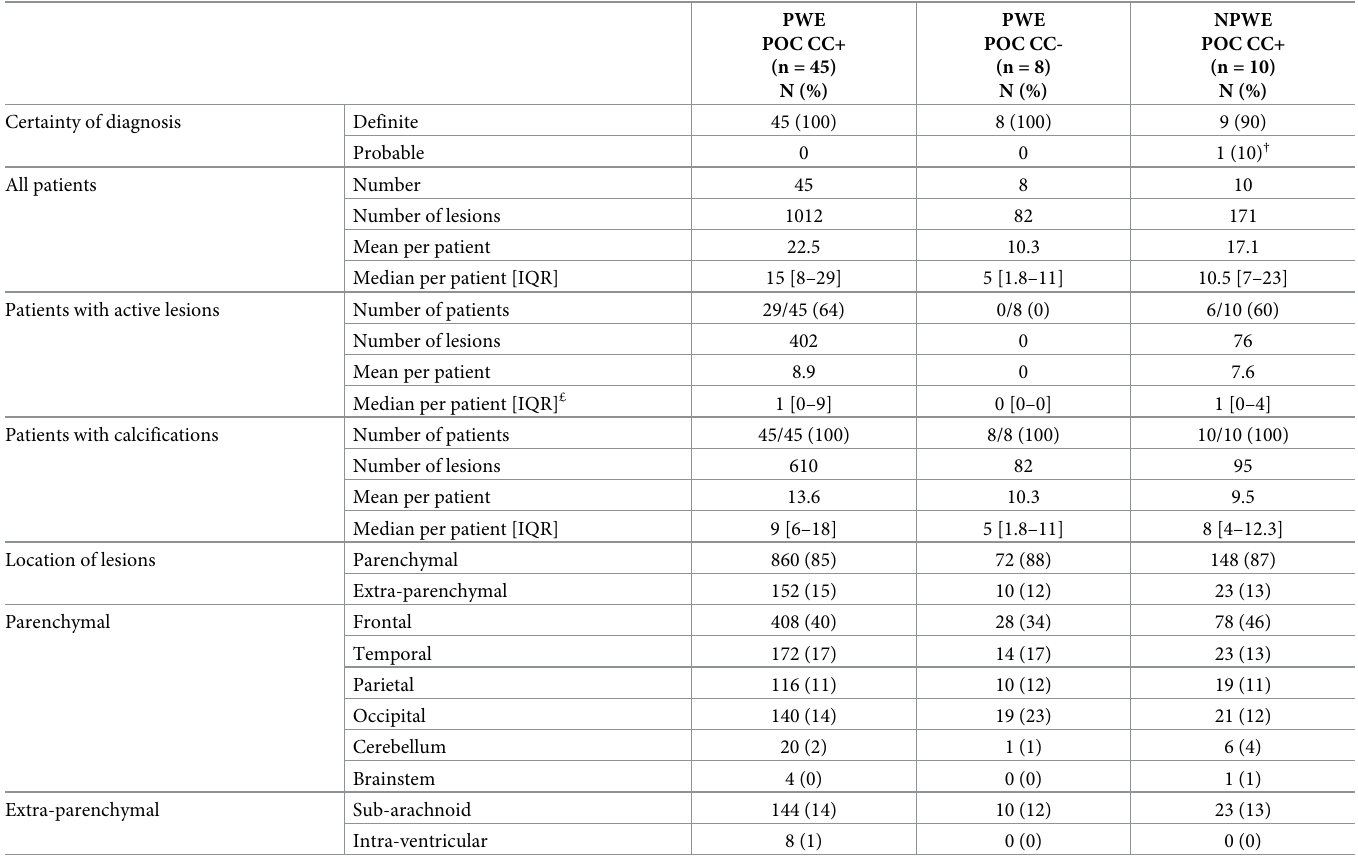
Table 4. Location of cysts among people with epileptic seizures and those without epileptic seizures.